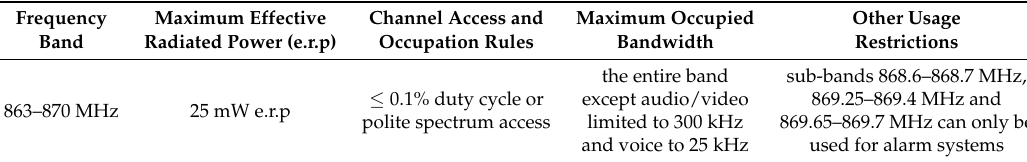
Table 5. Non-EU-wide harmonized National Radio Interfaces. Some European countries accept the use of the 863–870 MHz band with these characteristics. Channel access and occupation rules refers to the duty cycle that devices must respect. The other usage restrictions column indicates the applications that can take place and the transmission techniques than can be